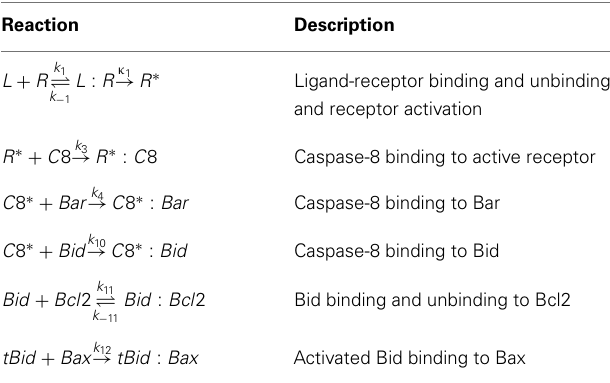
Table 2 | Reactions discovered to affect T d the most in sensitivity analysis